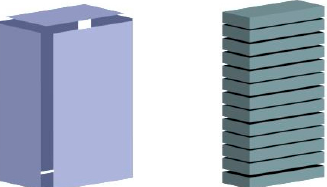
Figure 2. Split strategies: façade first split strategy and floor first split strategy.